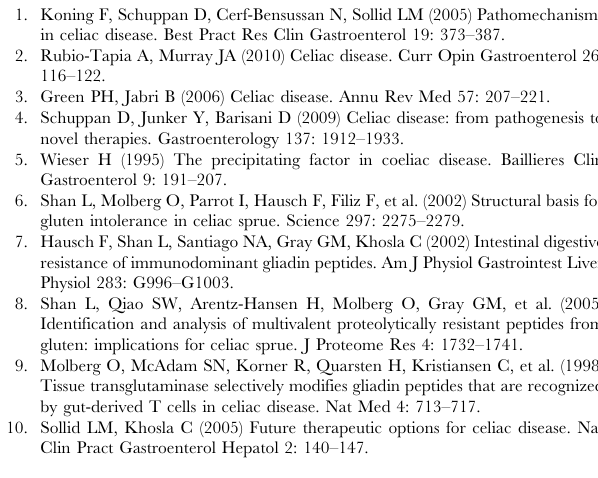
Figure S1 Degradation of the 26-mer by mammalian enzymes and by enzymes associated with R. aeria . The 26-mer peptide was incubated with pepsin (A), trypsin (B), chymotrypsin (C) (each 1 m g/ml) sampled at t= 0 and t= 24 h or in a suspension of WSA- 8 ( R. aeria ) cells (D; OD 620 1.2) sampled at t= 0, 30 min, 60 min and 120 min. Degradation of the 26-mer in incubation aliquots was monitored by RP-HPLC. (TIFF) Figure S2 Degradation and fragment analysis of the 26-mer incubated with R. aeria . Gliadin 26-mer (250 m g/ml) was incubation in a suspension of WSA-8 ( R. aeria ) cells (OD 620 1.2). Incubation aliquots removed after 0 h, 2 h and 5 h were analyzed by RP-HPLC (A). Degradation peaks labeled 1 to 10 were collected and sequenced by LC-ESI-MS/MS (B). Large solid arrows: cleavage after XPQ; large dotted arrows: cleavage after Q (except XPQ), small solid arrows: cleavage after QPY; small dotted arrows: other cleavages.